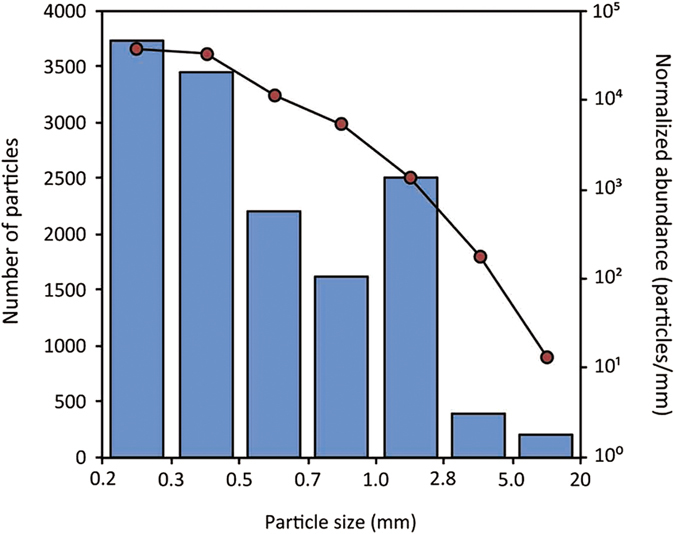
Size distribution of all particles collected during the survey.Normalized abundance values (red dots) were obtained by dividing the total number of particles counted in each size class (blue bars) by the width of the respective size bin expressed in millimeters8 (n = 14,106). Please note that fibers and filaments were not included and that only particles >700 μm were characterized through FT-IR spectroscopy. Secondary vertical axis is in logarithmic scale.